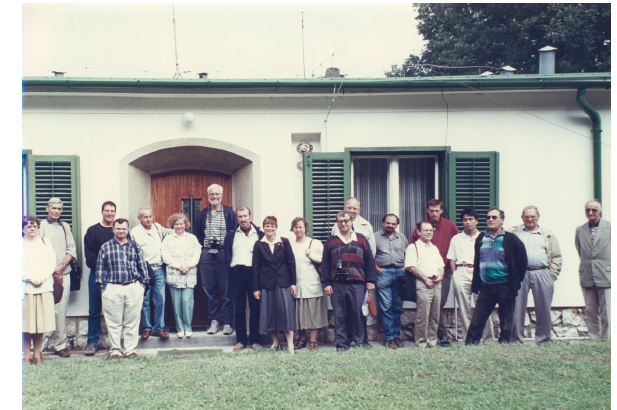
Figure 11. The first international workshop on Schumann reso- nances in Sopron, 7–10 September 1998. Visiting the Nagycenk Observatory, standing from left to right, were Judit Szendr˝oi,